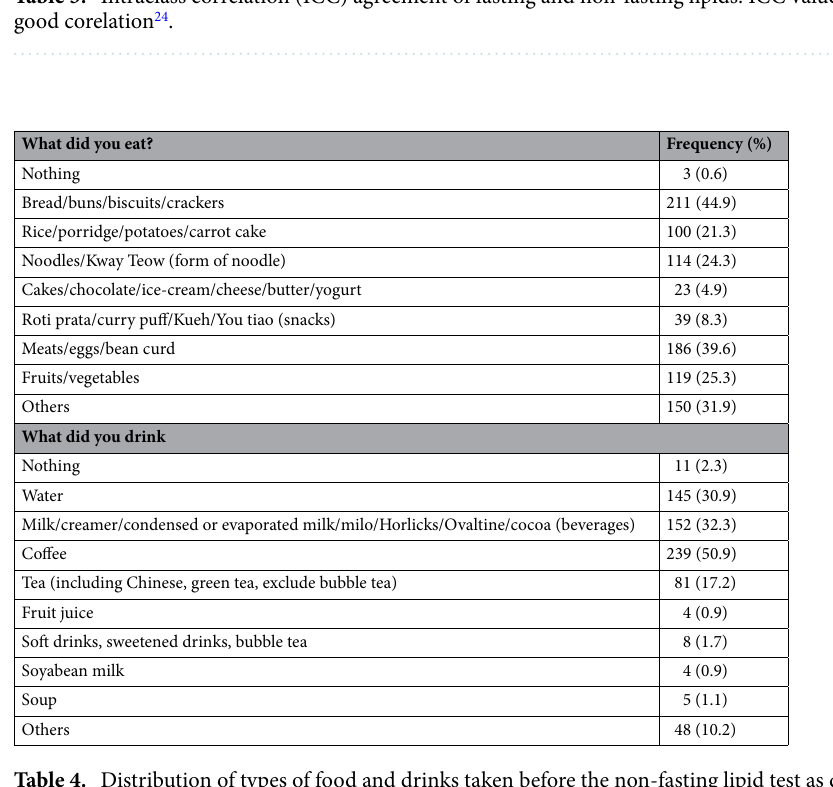
Table 4. Distribution of types of food and drinks taken before the non-fasting lipid test as declared by the subjects.